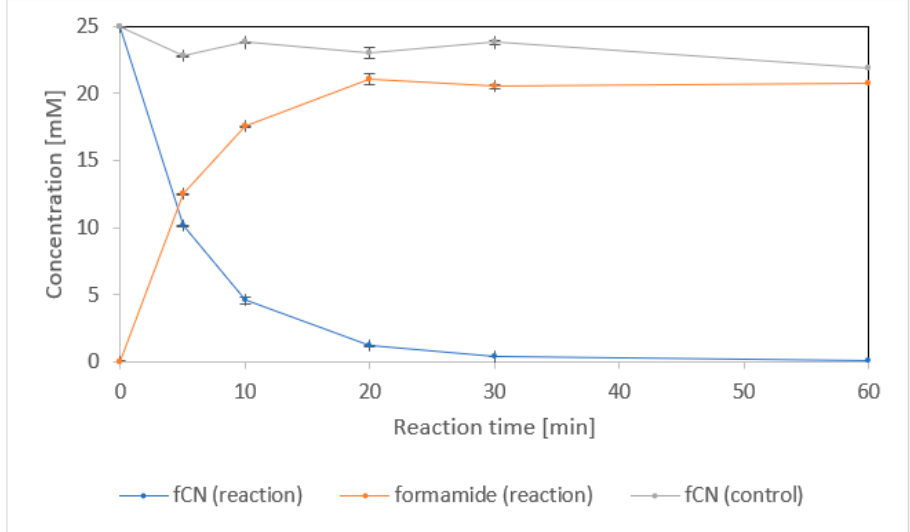
Figure 2. Transformation of 25 mM free cyanide (fCN) to formamide by enzyme NitEg (4.0 µg protein/mL) in 100 mM glycine/NaOH buffer, pH 9.0. Residual fCN concentration was determined by picric acid method. The enzyme was omitted from the control.